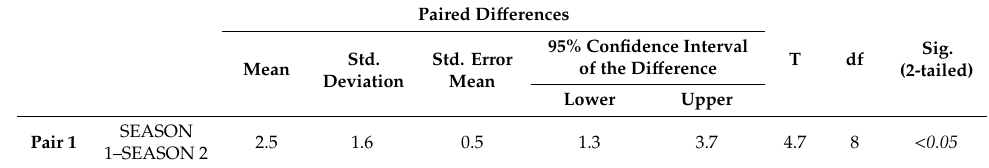
Table A10. Paired Samples Test.